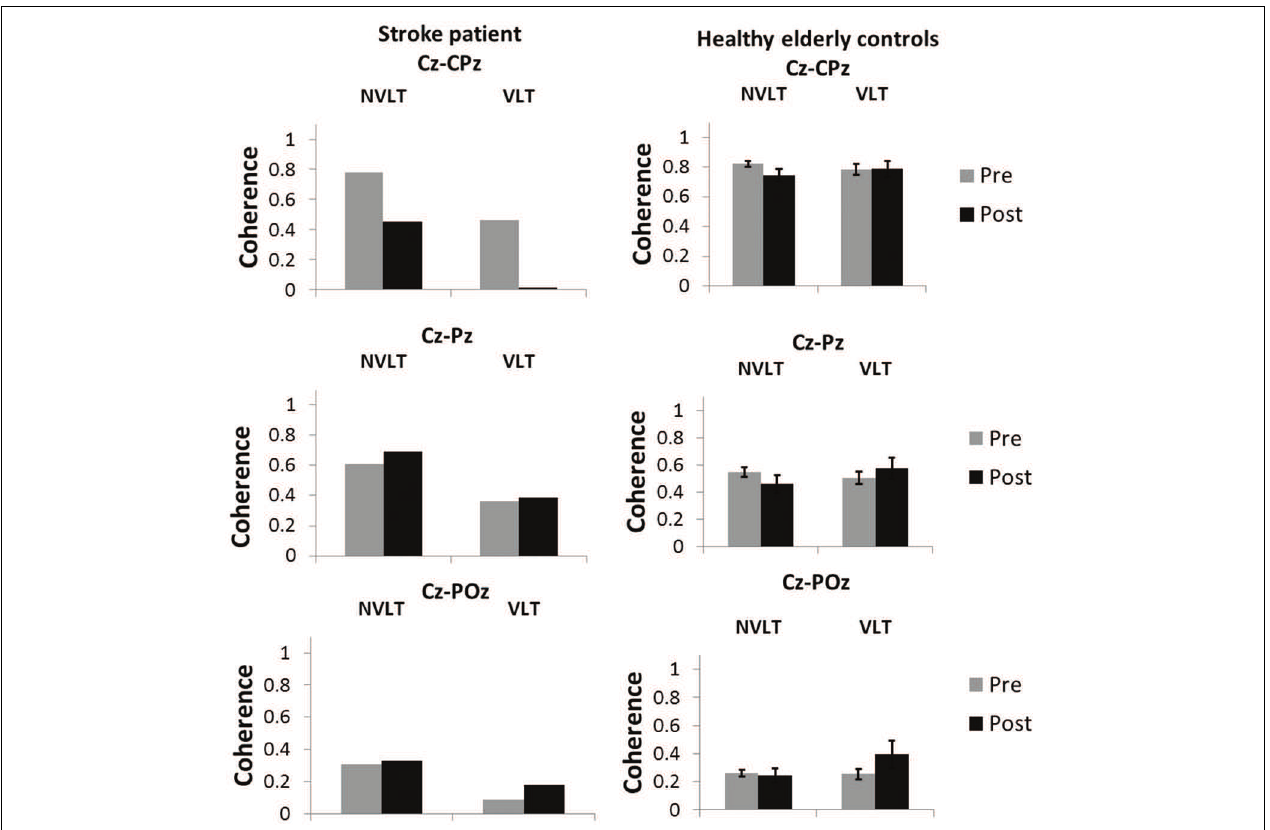
FIGURE 7 | Coherence values ( M and SE) in the SMR band (12–15 Hz) for the electrode pairs Cz-CPz, Cz-Pz and Cz-Poz for the healthy elderly group and stroke patient